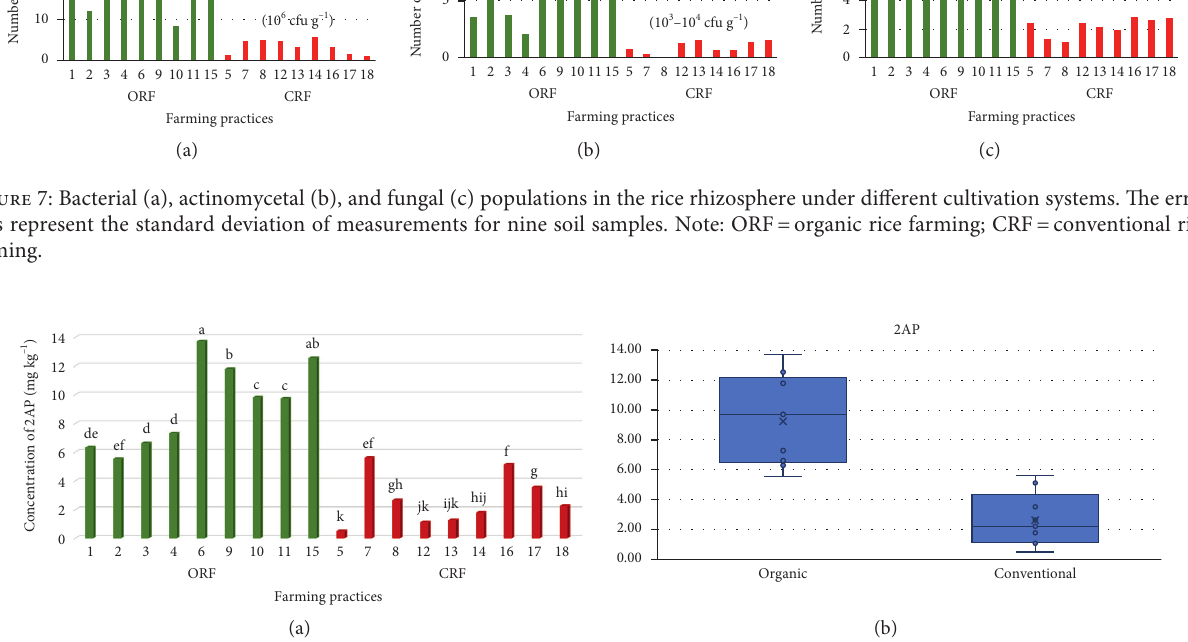
Figure 8: The 2-acetyl-1-pyrroline (2AP) contents of Khao Dawk Mali 105 (KDML105) grains grown under different cultivation systems. The error bars represent the standard deviation of measurements for nine soil samples. Note: ORF � organic rice farming; CRF � con- ventional rice